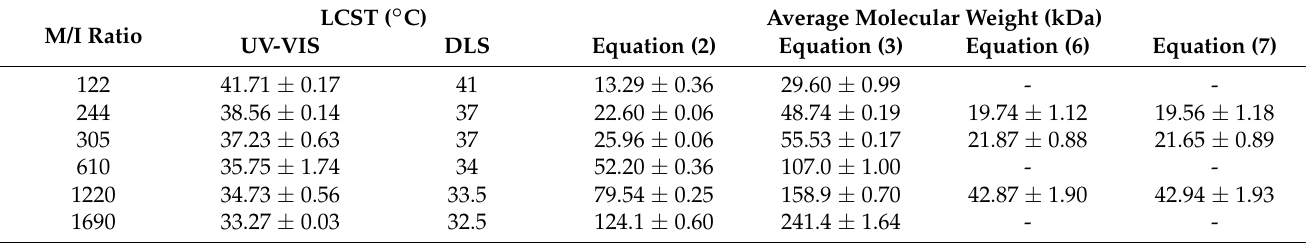
Table 1. LCST, average molecular weight and LCST of the synthesized PNVCL-COOH polymers. M/I